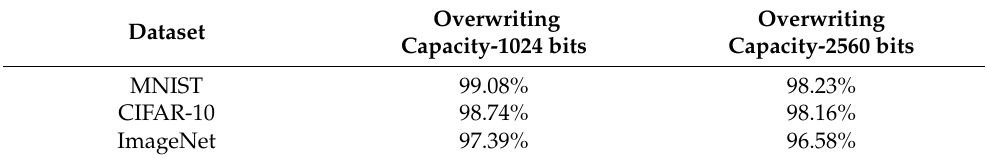
Table 5. Reserve of the original watermark after overwriting a 1024-bit or 2560-bit watermark.